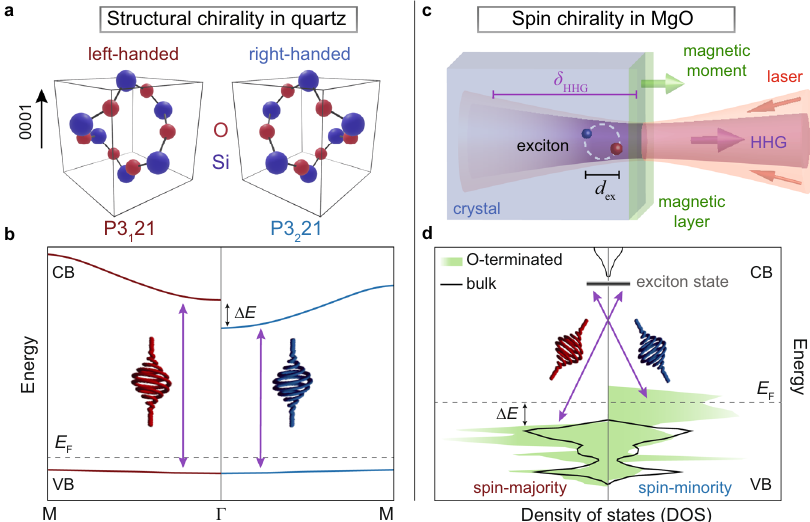
Fig. 4 Chirality in quartz and MgO. a Schematic of left- and right-handed enantiomers (P3 1 21 and P3 2 21) of quartz(0001). b Qualitative band structure of the two quartz(0001) enantiomers, adapted from ref. 33 . c Schematic of the high-harmonic generation (HHG) in MgO. Near-surface excitons with exciton diameter d ex may couple to the surface magnetic moment. Harmonic emission generated within the absorption length δ HHG is detected in our experiment. d Simpli fi ed surface density of states (DOS) for the oxygen-terminated MgO(111) surface (green, see also inset for crystal structure) and bulk MgO (black), adapted from ref. 39 (VB valence band, CB conduction band, E F fermi energy, Δ E band splitting). The purple arrows mark the excitations with opposite helicities of circularly polarized